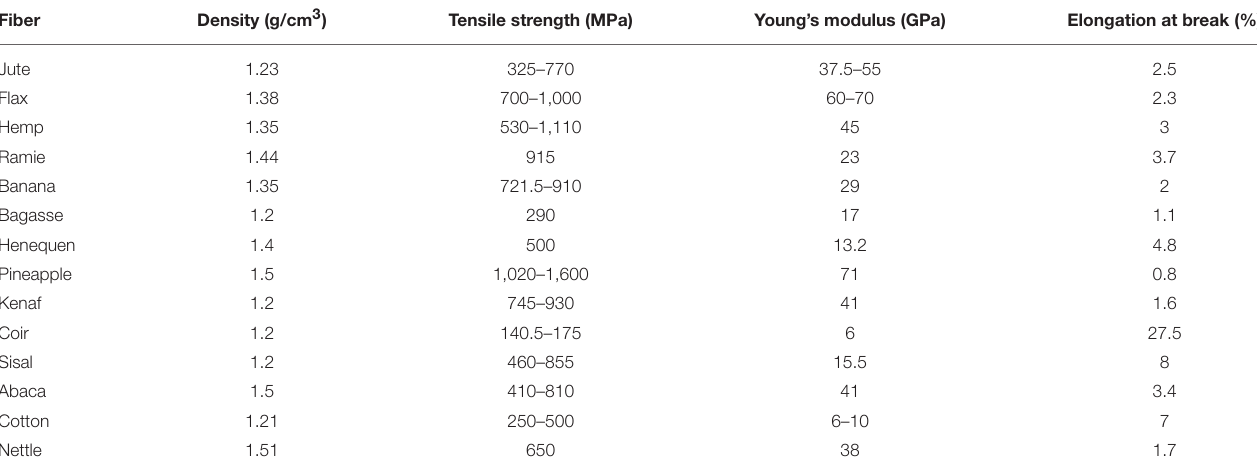
TABLE 2 | Properties of natural fibers (Pandey et al., 2010; Ku et al., 2011; Komuraiah et al., 2014; Gurunathan et al., 2015). Fiber Density (g/cm 3 ) Tensile strength (MPa) Young’s modulus (GPa) Elongation at break